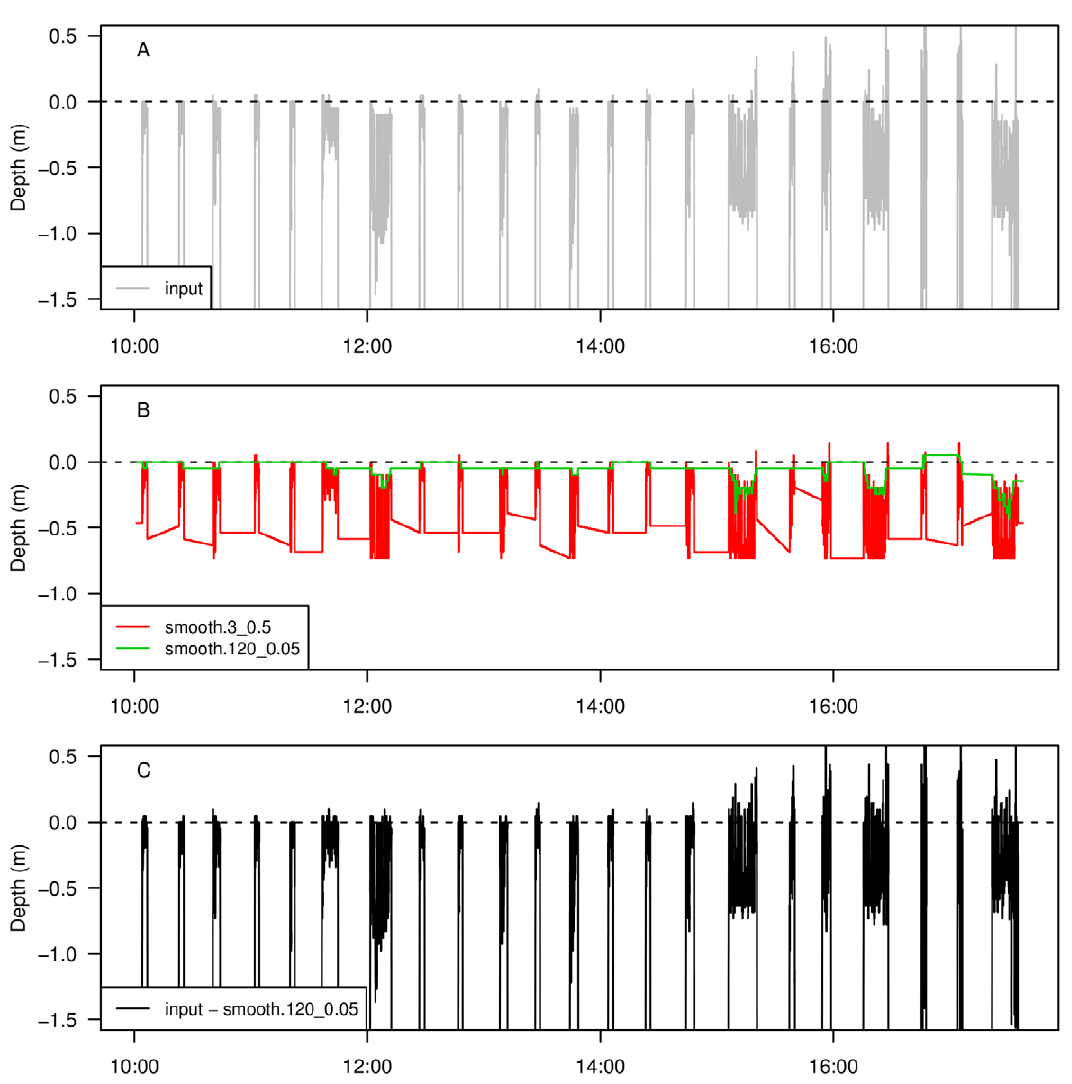
Figure 4. Zero offset correction of TDR data from a leatherback turtle. Input time series (A), first filter (median) using a moving window of size 3 (3 s) and second filter (0.05 quantile) using moving window of size 120 (2 min) (B), and corrected depth (input series minus last filter) (C). The y- axis limits are restricted to be approximately equal to the range of surface depth in the time series for clarity.